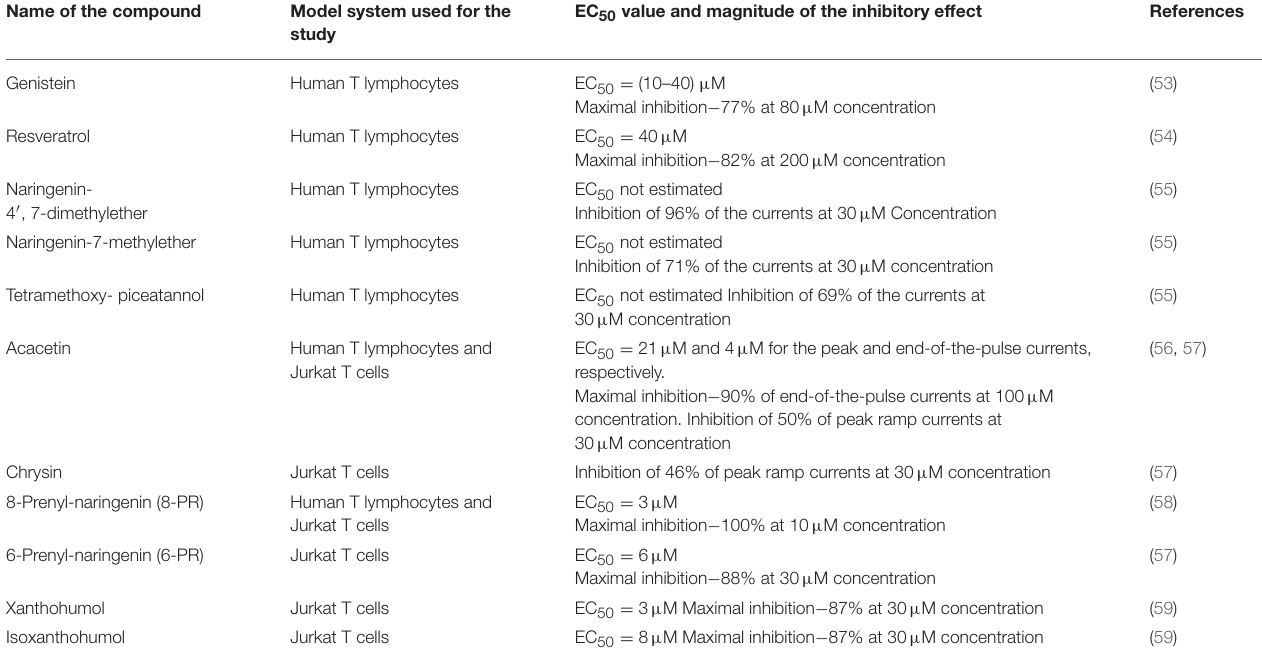
TABLE 3 | Inhibition of Kv1.3 channels by non-prenylated and prenylated flavonoids and substituted